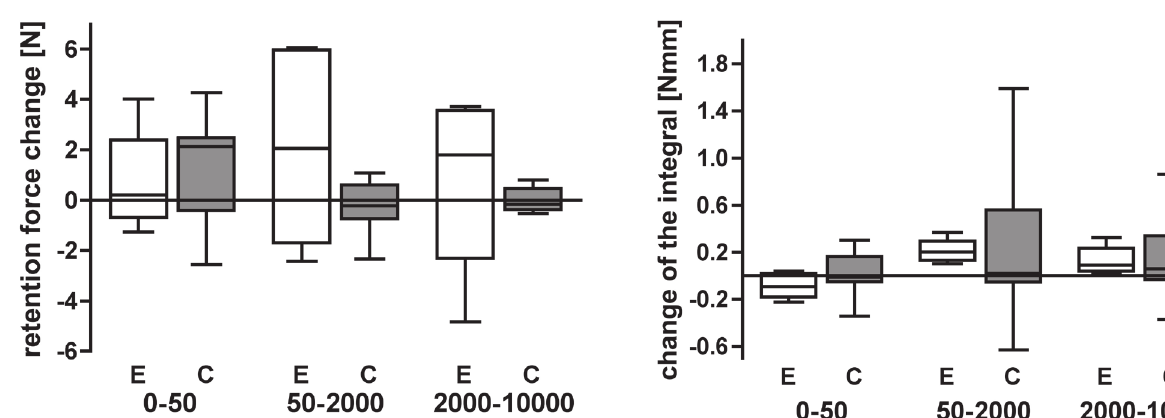
Figure 7- Comparison of the changes of the force- distance integral of the two groups (E=electroplated female part, C=cast female part). The three phases are shown: start phase (cycle 0-50), initial phase (cycle 50- 2,000), wear period (cycle 2,000-10,000)